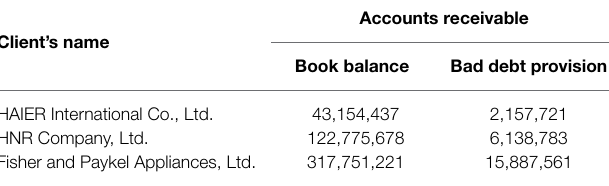
TABLE 7 | Haier’s new accounts receivable in